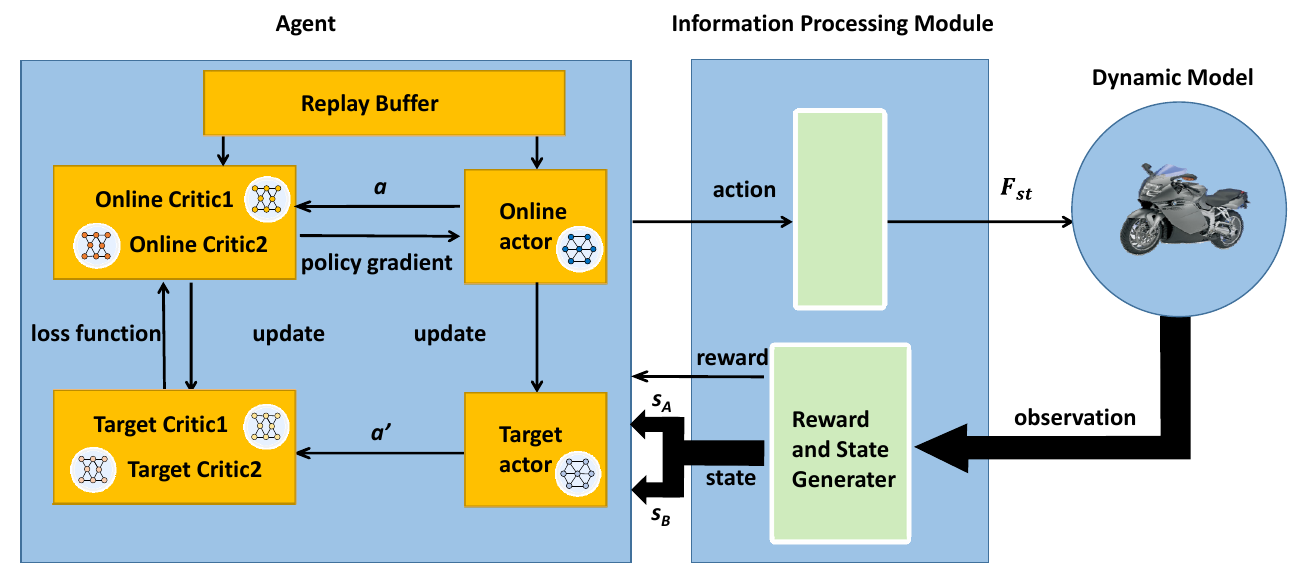
Figure 5. The framework of the STTW robots reinforcement learning control method.